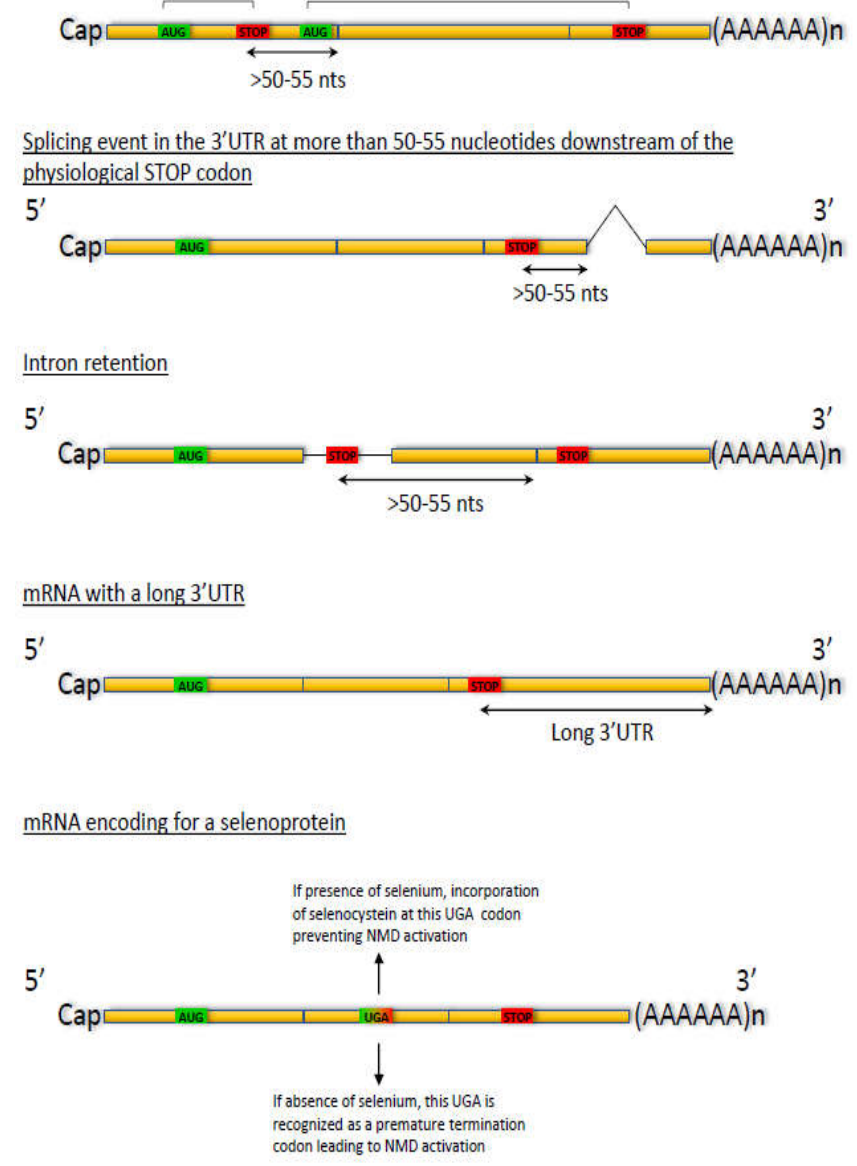
Figure 2. Examples of natural NMD substrates. Topmost example: Presence of a small open reading frame upstream of the main open reading frame. If the ribosome reads this small open reading frame, the stop codon of this ORF is recognized as a PTC because of the presence of downstream exon-exon junctions. Consequently, NMD of this mRNA is activated. If the ribosome reads the main open reading frame, no PTC is detected on this mRNA and its degradation through NMD is not activated. Second example: Part of the 3’UTR is removed by splicing. This splicing event results in EJC deposition 20–24 nucleotides upstream of the splicing event and hence in recognition of the physiological stop codon as a PTC if the splicing event is located more than 50–55 nucleotides downstream of the physiological stop codon. Third example: Changes in the splicing profile of a pre-mRNA lead, for example, to intron retention or exon skipping. These events very often lead to introduction of a PTC and hence to activation of NMD of this mRNA. Example four: In mRNAs having a long to very long 3 (cid:48) UTR, the physiological stop codon is recognized as a PTC and NMD